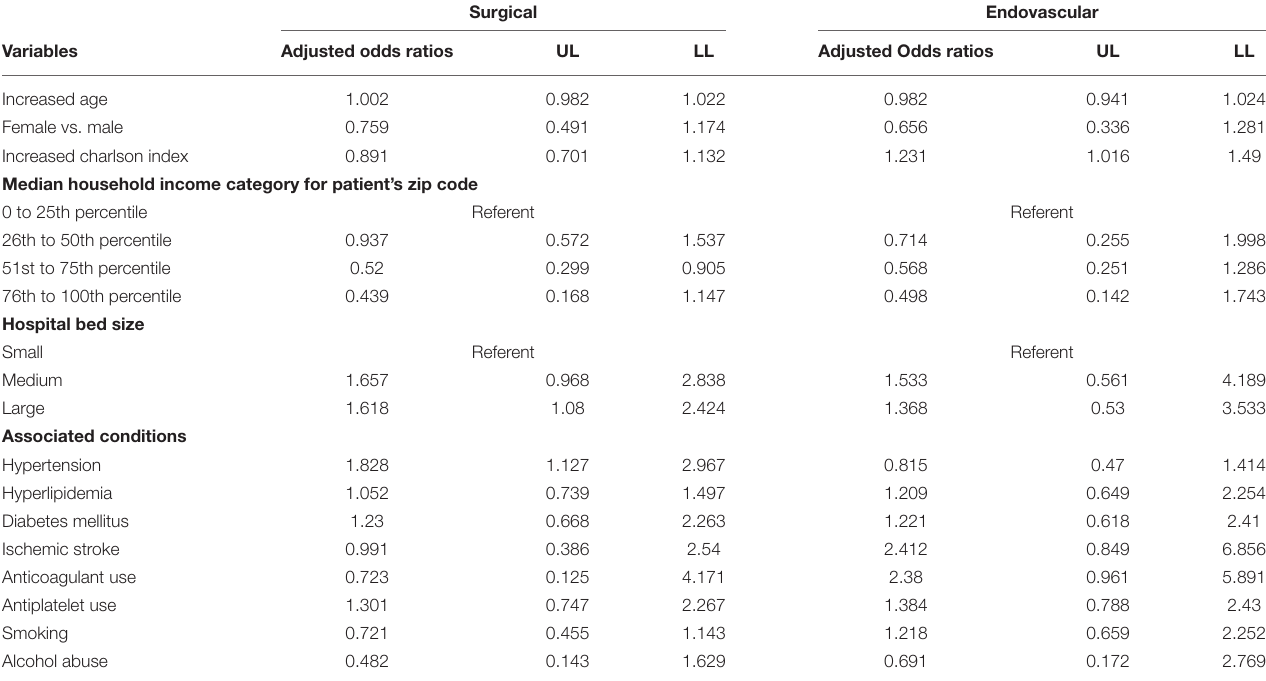
TABLE 2 | Characteristics of readmitted